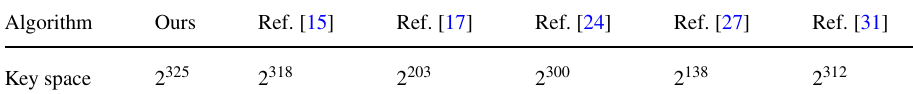
Table 3 MSE and PSNR